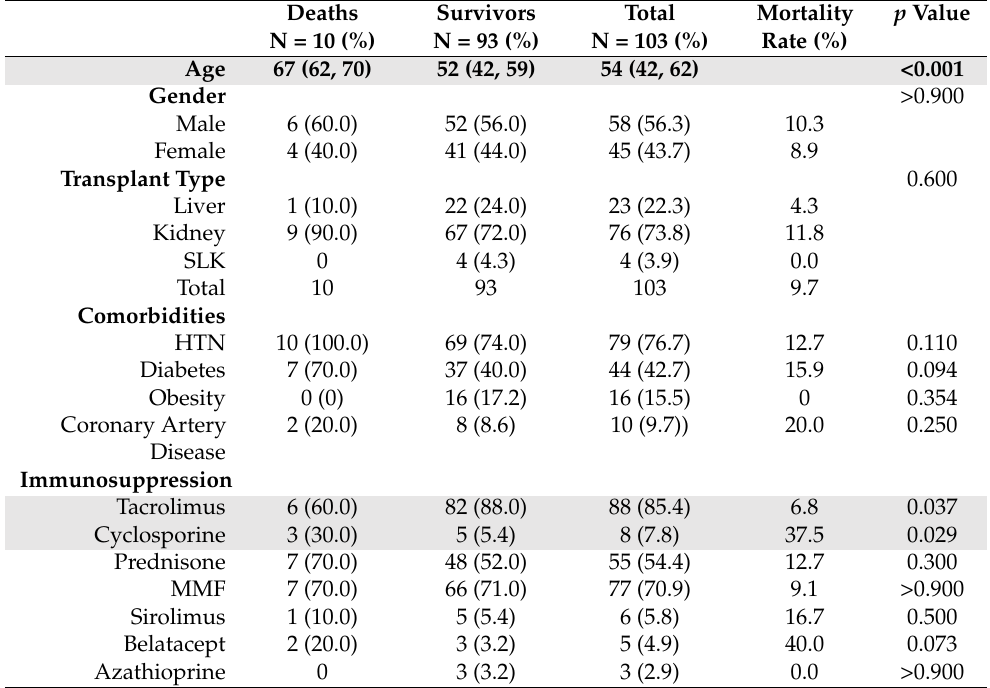
Table 1. Patient Demographics, Transplant Type, Comorbidities, and Immunosuppression. Age reported as Median (IQR); analyzed with Wilcoxon rank sum test. Categorical variables reported as n (%); analyzed with Fisher’s exact test. Deaths Survivors Total N = 10 (%) N = 93 (%) N = 103